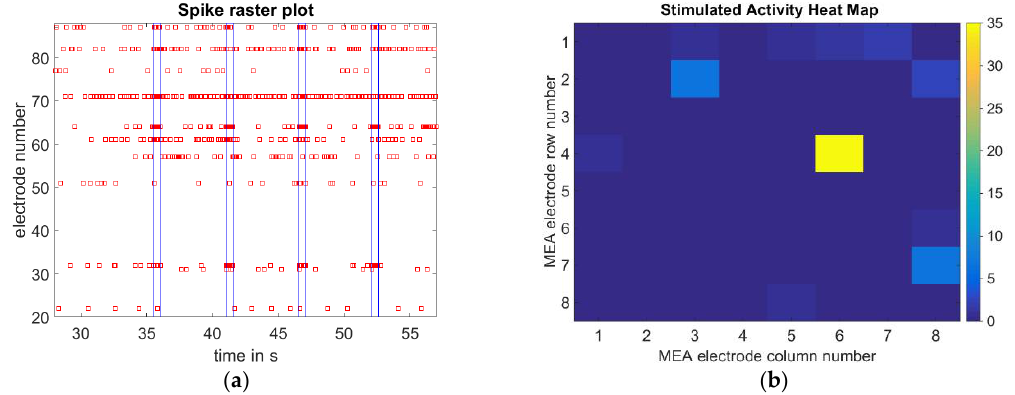
Figure 8. ( a ) Section of the raster plot for full-field stimulation. Red dots show the action potentials recorded by all electrodes. The blue vertical lines indicate the time windows of 500 ms full field optical stimulation. A high spontaneous, i.e., unstimulated activity is present in the network, stimulation leads to increased activity on some electrodes. ( b ) Full field stimulation activity heat map showing the mean per-electrode activity in spikes per second during optical stimulation.